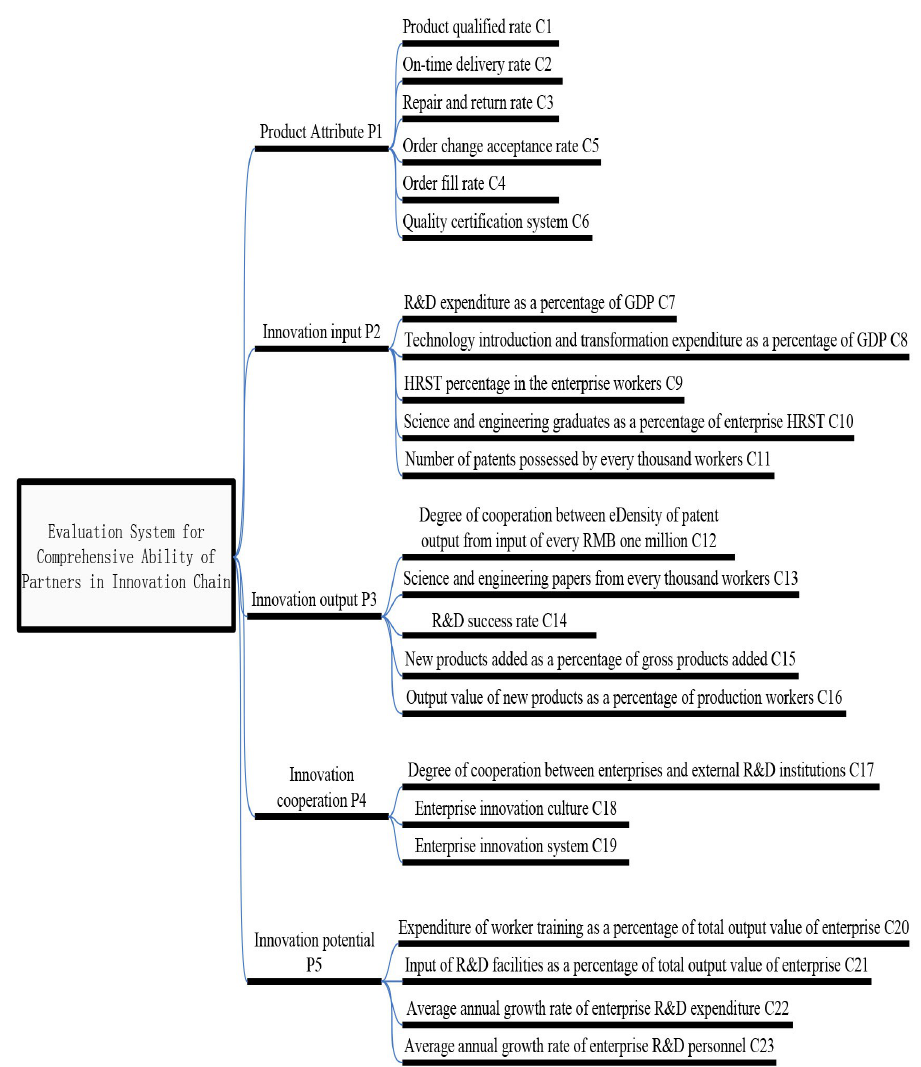
Figure 1.Evaluation Index System for Supplier in Innovation Chain-oriented Public